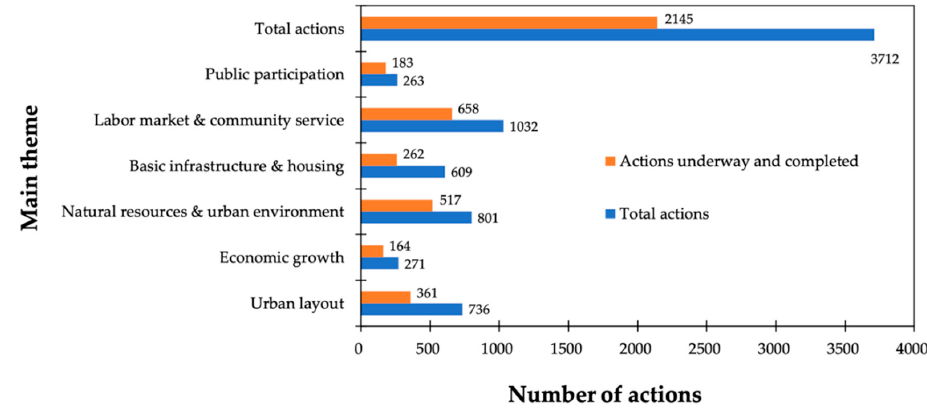
Figure 3. Distribution of the actions by the LA21 thematic areas [26].